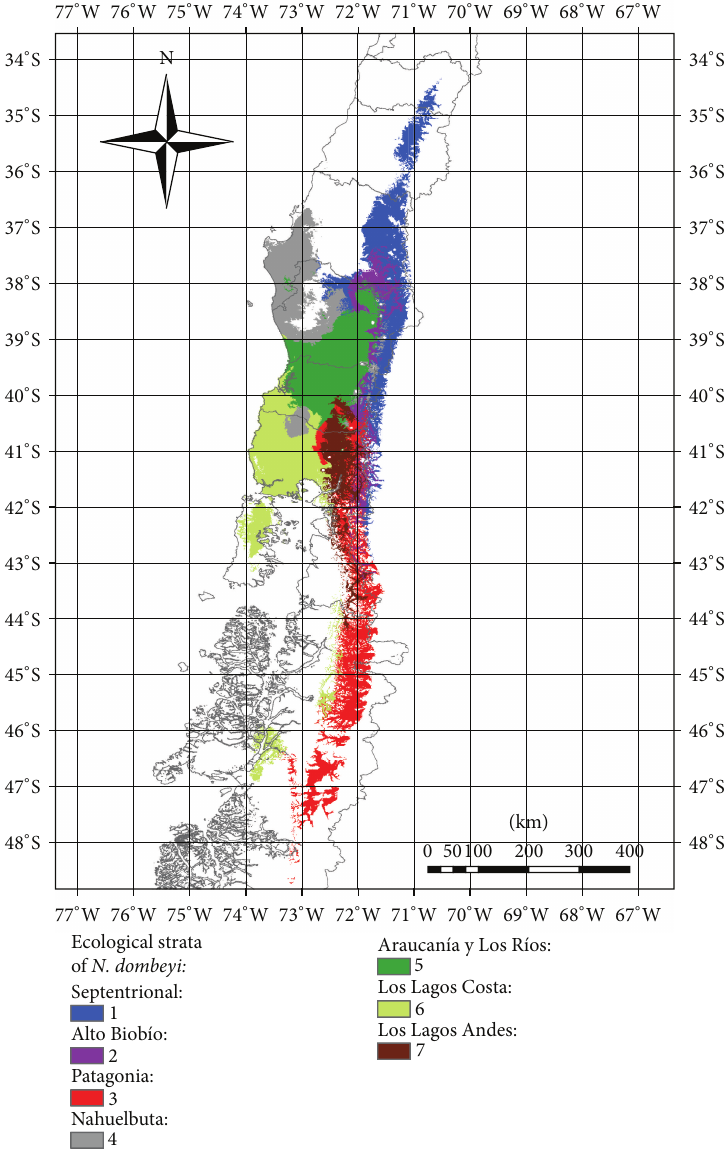
individuals with 10,109 binary SNP from seven strata. This dataset was subjected to the impute step and finally total numbers of “NN” genotypes were 19,067 (0.03%) missing